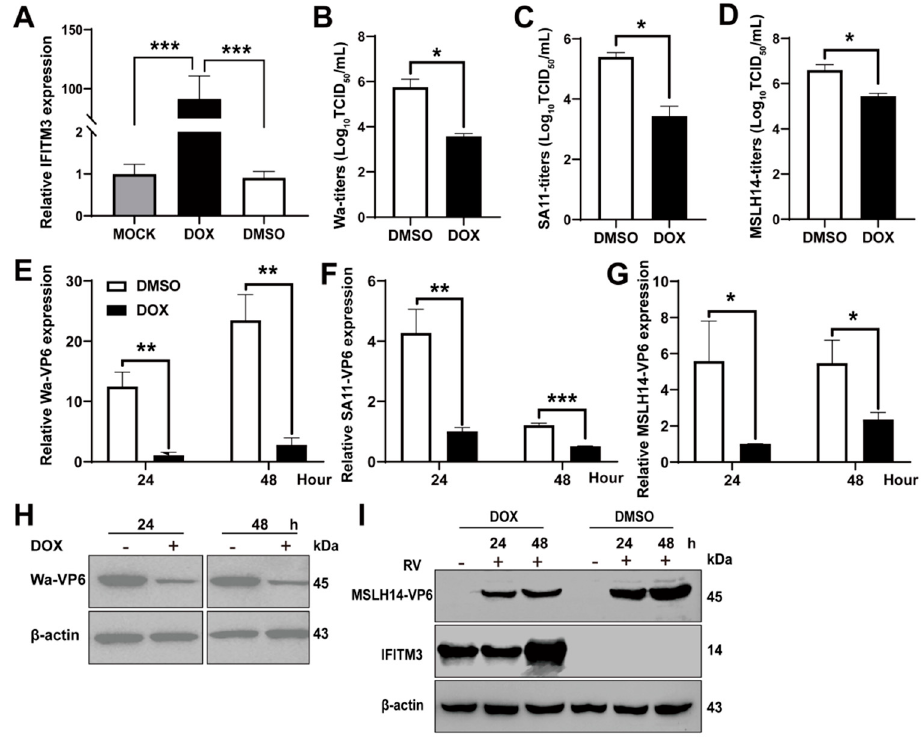
Figure 3. Over–expression of IFITM3 inhibits RV replication in MDCK–Tet3G–IFITM3 cells. ( A ) RT–qPCR analysis of IFITM3 in MDCK–Tet3G–IFITM3 cells after DOX and DMSO treatment. ( B – D ) Infectious progeny viral titers in MDCK–Tet3G–IFITM3 cells with or without DOX treatment. The viral titers of the Wa strain, SA11 strain and MSLH14 strain in cells were determined by TCID50. ( E – G ) RT–qPCR analysis of VP6 in MDCK–Tet3G–IFITM3 cells infected with the Wa strain, SA11 strain and MSLH14 strain, respectively, at 0.2 MOI for the indicated time. ( H ) Western blot analysis of Wa–VP6 in MDCK–Tet3G–IFITM3 cells after DOX and DMSO treatment. ( I ) Western blot analysis of MSLH14–VP6 in MDCK–Tet3G–IFITM3 cells after DOX and DMSO treatment. ( A – G ) Results represented the mean ± SD and were measured in technical duplicates, n = 3. *, p < 0.05; **, p < 0.01; ***, p <0.001 (Student’s t test).